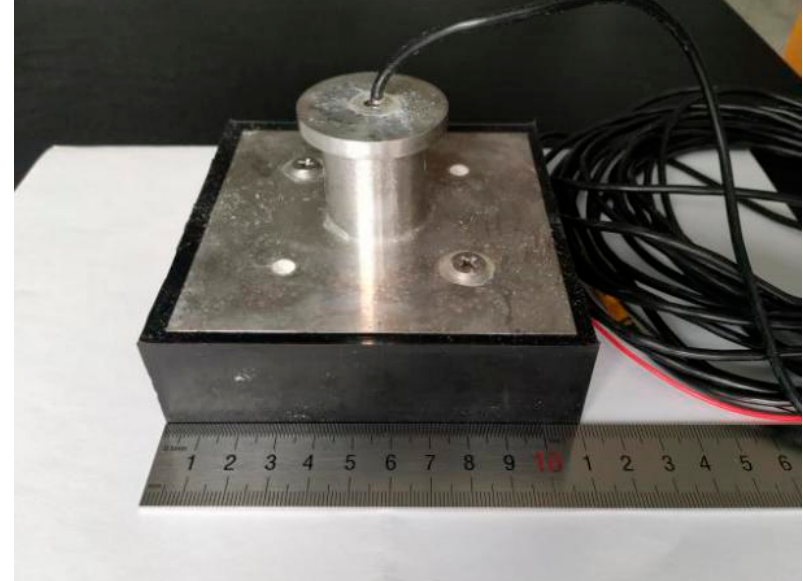
Figure 12. Physical diagram of the underwater acoustic transducer.